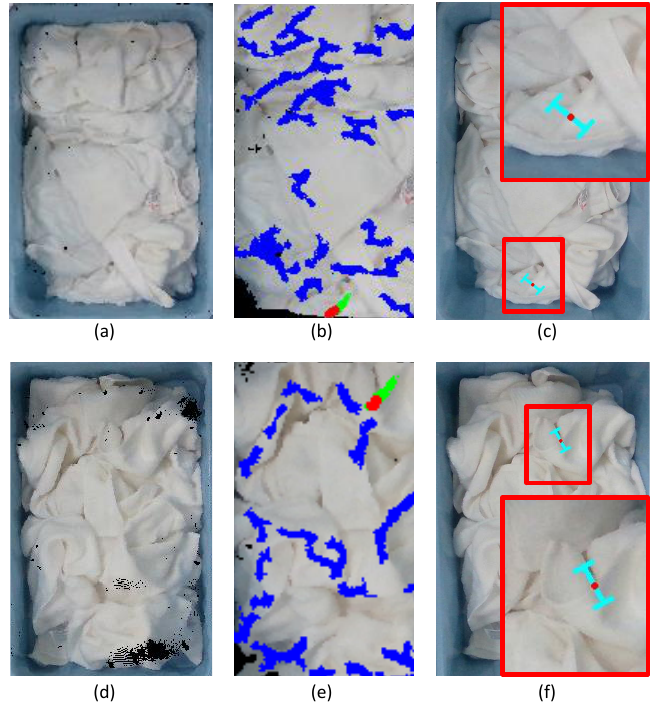
Figure 10. The grasp pose in scene 2: ( a ) the point clouds of the white towels in a laundry basket; ( b ) the grasp point on the candidate convex wrinkle; ( c ) the projection of a grasp pose on the image; ( d ) the point clouds of the white square towels in a laundry basket; ( e ) the grasp point on the candidate convex wrinkle; ( f ) the projection of a grasp pose on the image.